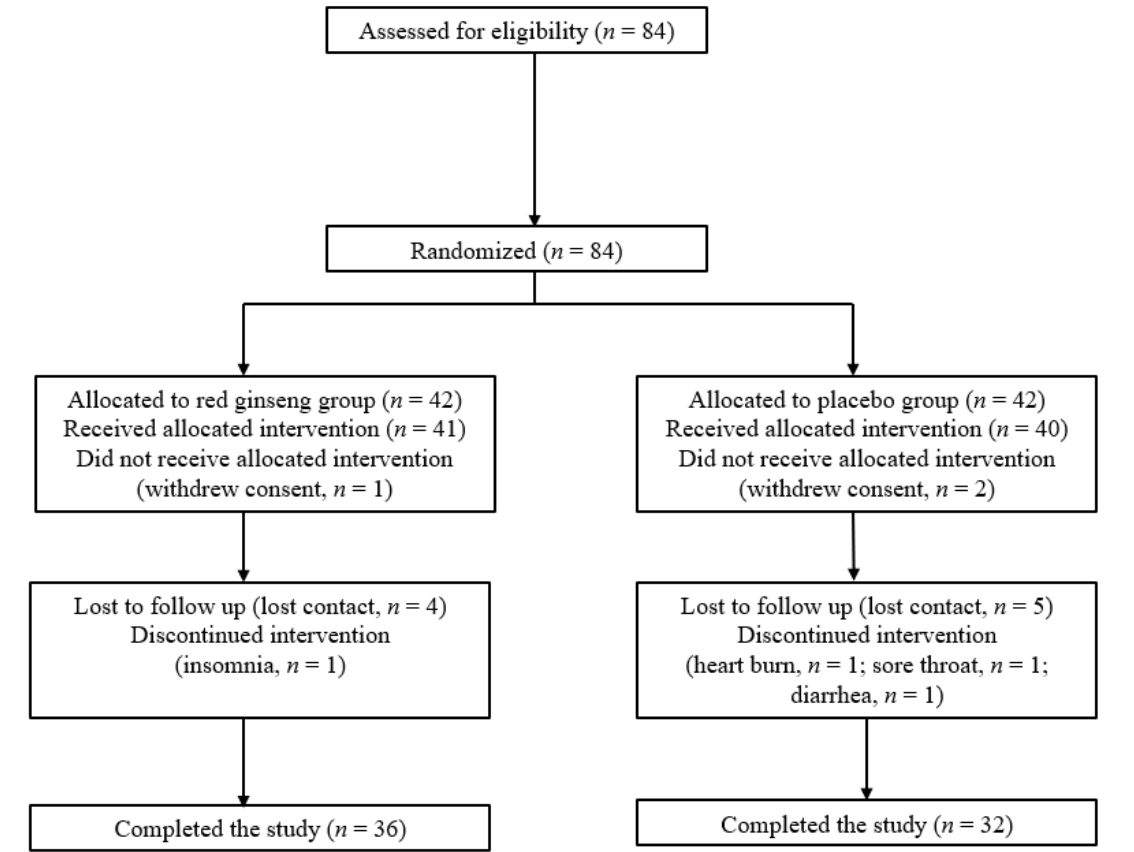
Figure 1. Flow chart of the study population.